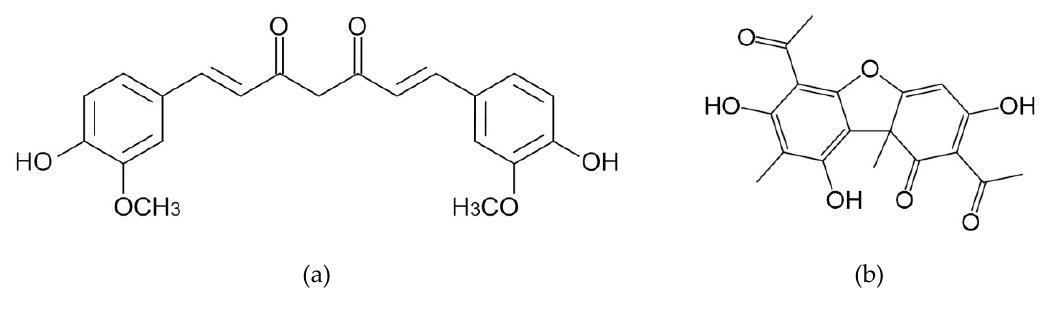
Figure 1. Chemical structure of curcumin ( a ) and usnic acid ( b ).